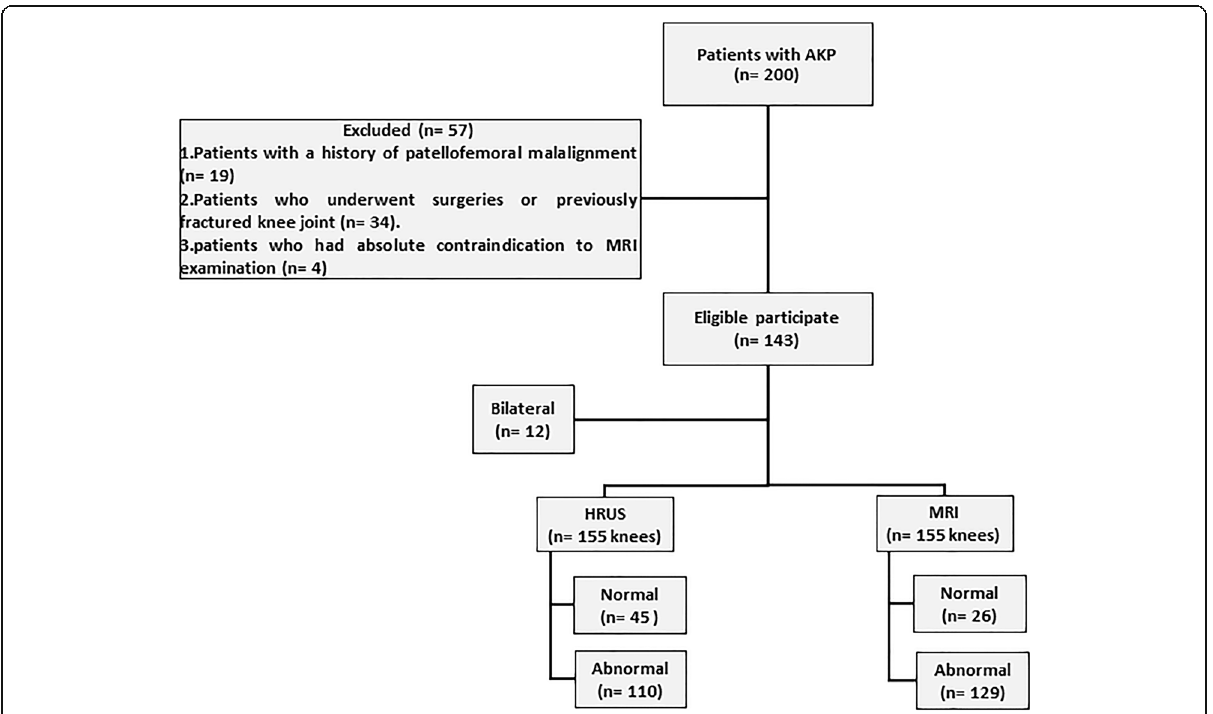
Fig. 1 Flow chart of our study. AKP, anterior knee pain; n, number; MRI, magnetic resonance